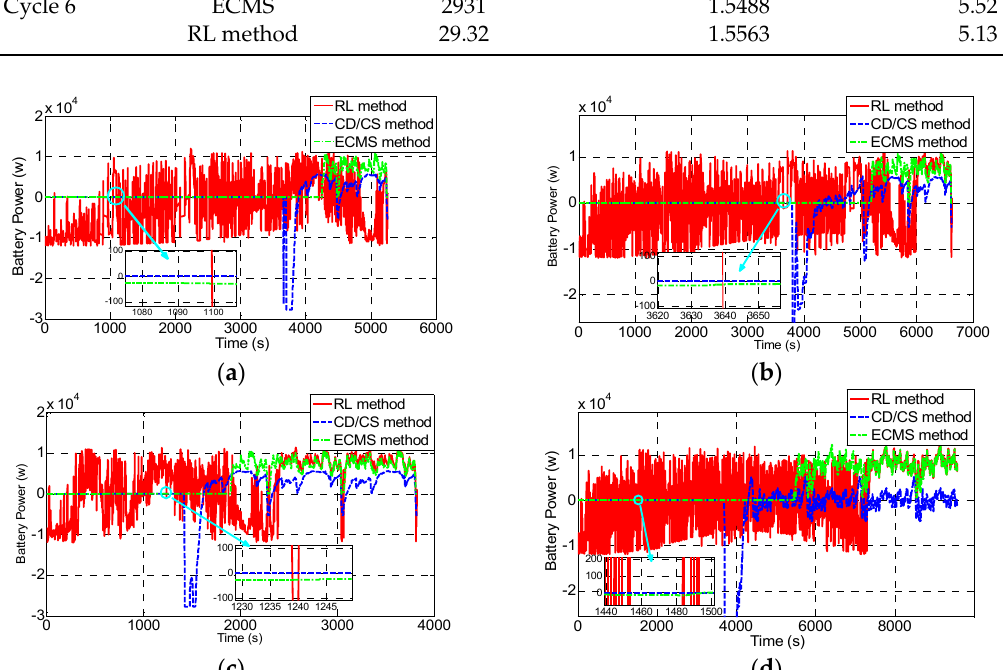
Figure 10. Battery power comparison under driving cycles. ( a ) Cycle 1; ( b ) Cycle 2; ( c ) Cycle 3; and ( d ) Cycle 6.